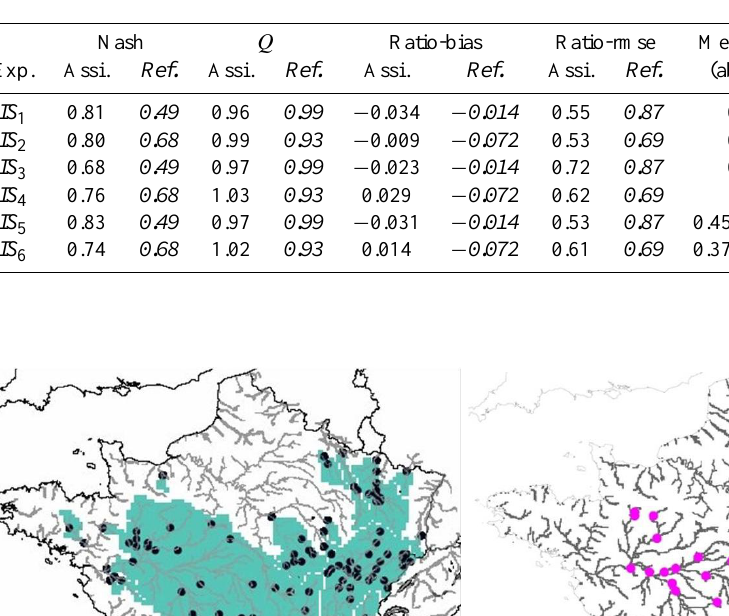
Table 3. Statistical scores for SIM discharges and the BLUE assimilation system for a set of 148 assimilated stations. Scores are averaged over a 19-month period (10 March 2005–30 September 2006). Nash, Q , Ratio-bias and Ratio-rmse scores are presented for each assimilation experiment (straight) and its corresponding reference simulation ( italics ). “Mean incr. (abs.)” stands for the mean of the absolute values of the increments imposed by the BLUE analysis, and “Incr. σ ” stands for the spread of these increments. As the BLUE gives separate increments for layers 2 and 3 of ISBA for experiments IS 5 and IS 6 , the two last columns are split into two sub-columns with mean and spread of increments for layer 2 (left) and for layer 3 (right).